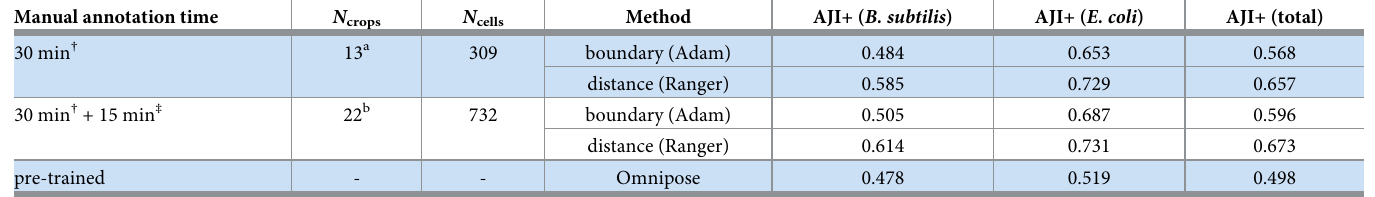
Table 1. microbeSEG accuracy in dependence of annotation time. All methods are evaluated on 12 B. subtilis and 12 E. coli test images. For each microbeSEG setting, the median aggregated Jaccard index AJI+ out of five trained models is shown. The times include the crop selection.